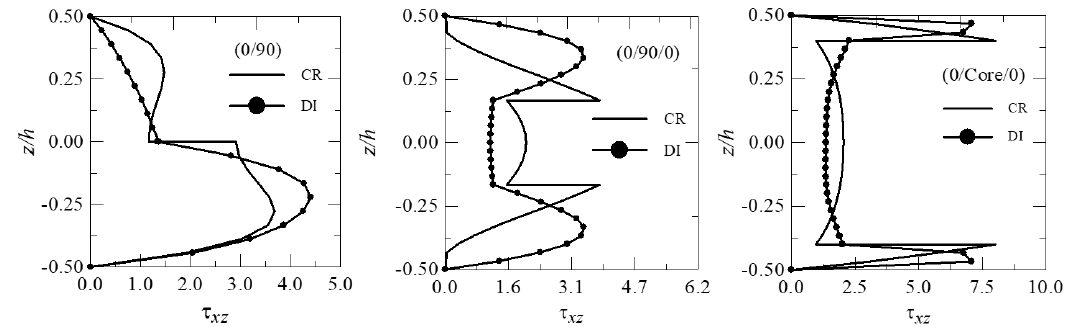
Figure 5: Through-the-thickness variations of transverse shear stresses for laminated and sandwich beams curved in elevation ( L/h= 4, R/h=